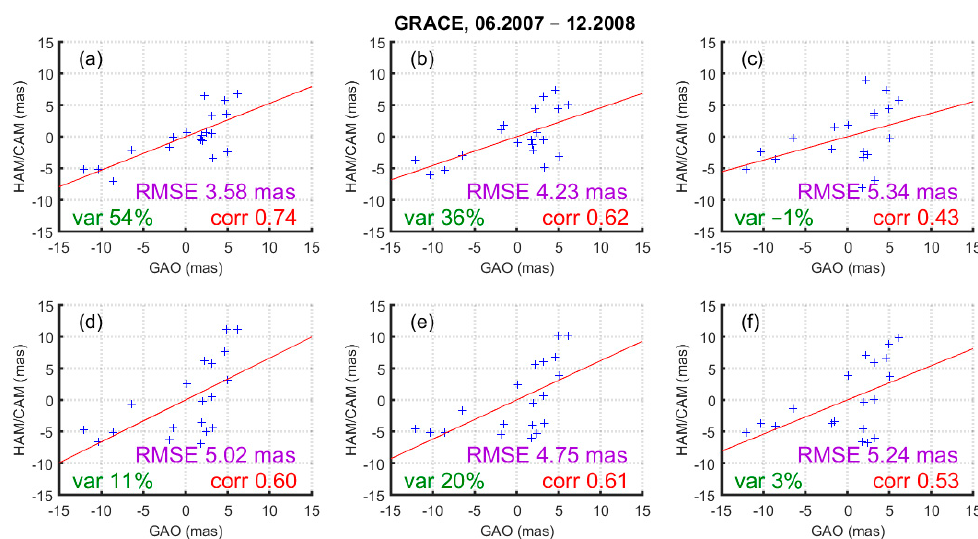
Figure 8. Scatter plots showing the relationship between the χ 1 component of GAO and HAM/CAM from ( a ) CSR GSM, ( b ) JPL GSM, ( c ) GFZ GSM, ( d ) CSR TWS, ( e ) JPL TWS, and ( f ) GFZ TWS. The red line was fitted to the data points using the least squares method. The values in purple indicate the RMSE, the values in red (corr) indicate the correlation coefficients between series, and the values in green (var) indicate the relative explained variances. The considered time period is June 2007 to December 2008. Note that the critical value of correlation coefficient for 12 independent points and a 95% confidence level is 0.50, while the standard error of the difference between two correlation coefficients is 0.47. All the parameters were computed after removal of trends.